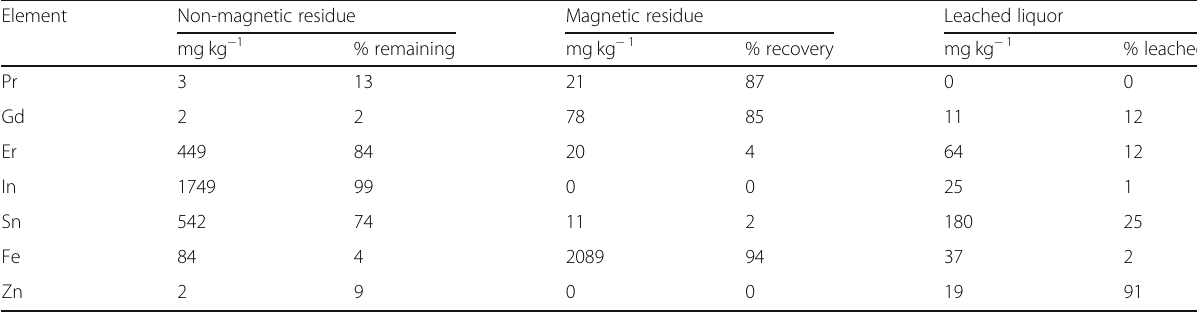
Table 1 Results of the ICP analysis of the leach liquor, the magnetic and non-magnetic residues Element Non-magnetic residue Magnetic